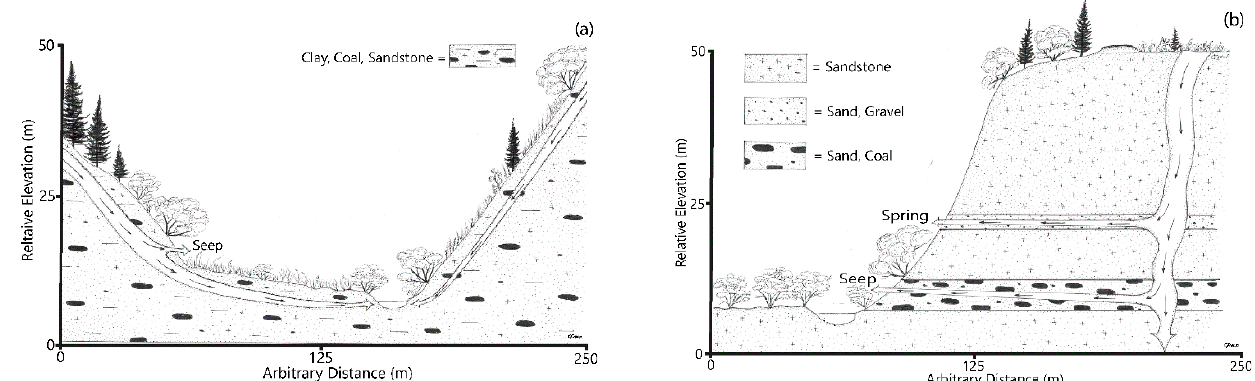
Figure 3. Types of groundwater discharge include ( a ) hillslope groundwater discharge and ( b ) aquifer-outcrop groundwater discharge. Illustrations drawn by Conrad Field from field sketches and notes prepared by Mark Rains.